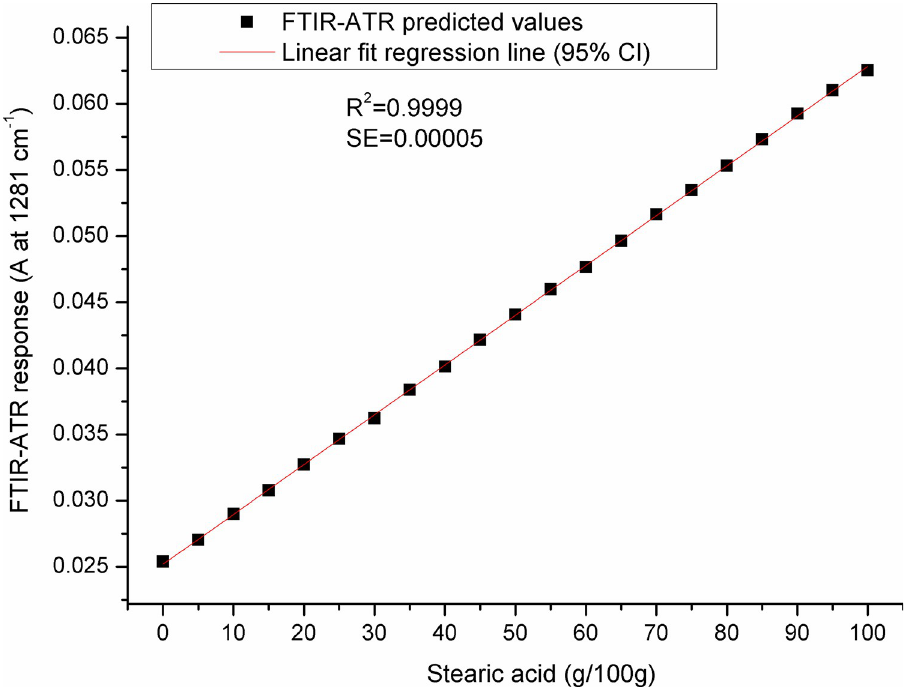
Fig 11. A scatter plot of FTIR-ATR predicted values (instrument response) versus real (known) stearic acid share values using the spectral region with an absorption maximum at 11281 cm -1 .